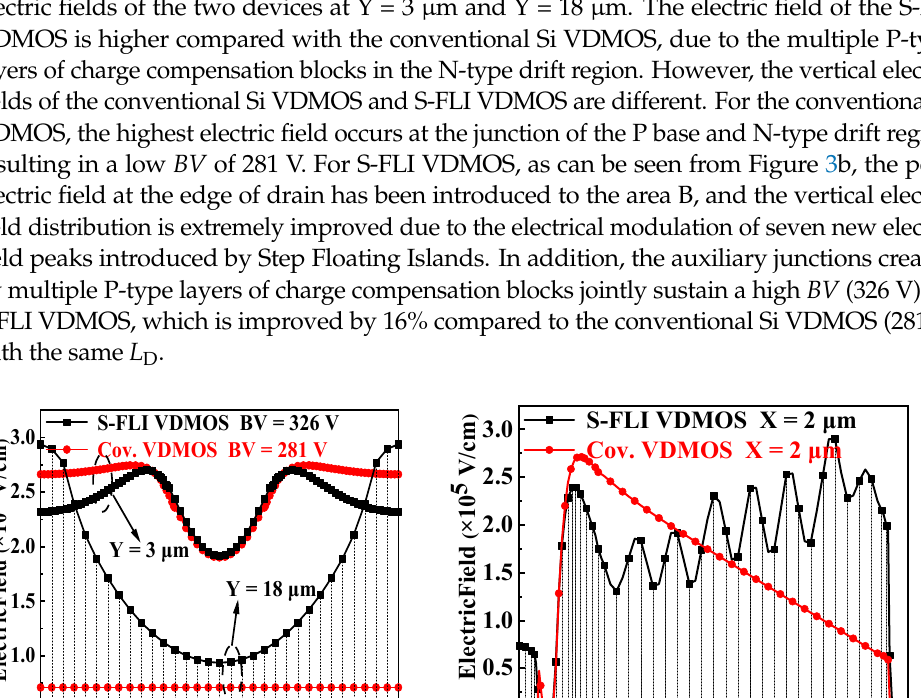
( c ) Figure 5. Dependences of ( a ) BV , ( b ) R on,sp and ( c ) figure-of-merit ( FOM ) on L D for the conventional Si VDMOS and S-FLI VDMOS. Figure 6 shows the distribution and flowing paths of total current for the conven- tional Si VDMOS and S-FLI VDMOS in on-state. Since the P-type S-FLI assists in depleting the N-type drift region in the off-state so that the optimum N D is further increased, the current density for the proposed S-FLI VDMOS is higher compared to conventional Si VDMOS; thus, it is helpful for the R on,sp . Source Gate Cov. VDMOS R on,sp = 21.5 mΩ·cm 2 7.8×10 -3 8.3×10 -10 8.3×10 -17 9.4×10 -24 1.0×10 -30 TotalCurrentDensity 7.3×10 4 Source Gate S-FLI VDMOS R on,sp = 7.8 mΩ·cm 2 1.7×10 5 1.6×10 -2 1.4×10 -9 1.2×10 -16 1.1×10 -23 1.0×10 -30 TotalCurrentDensity ( a ) ( b ) Figure 6. The distribution and flowing paths of total current for the ( a ) conventional Si VDMOS and ( b ) S-FLI VDMOS in on-state.